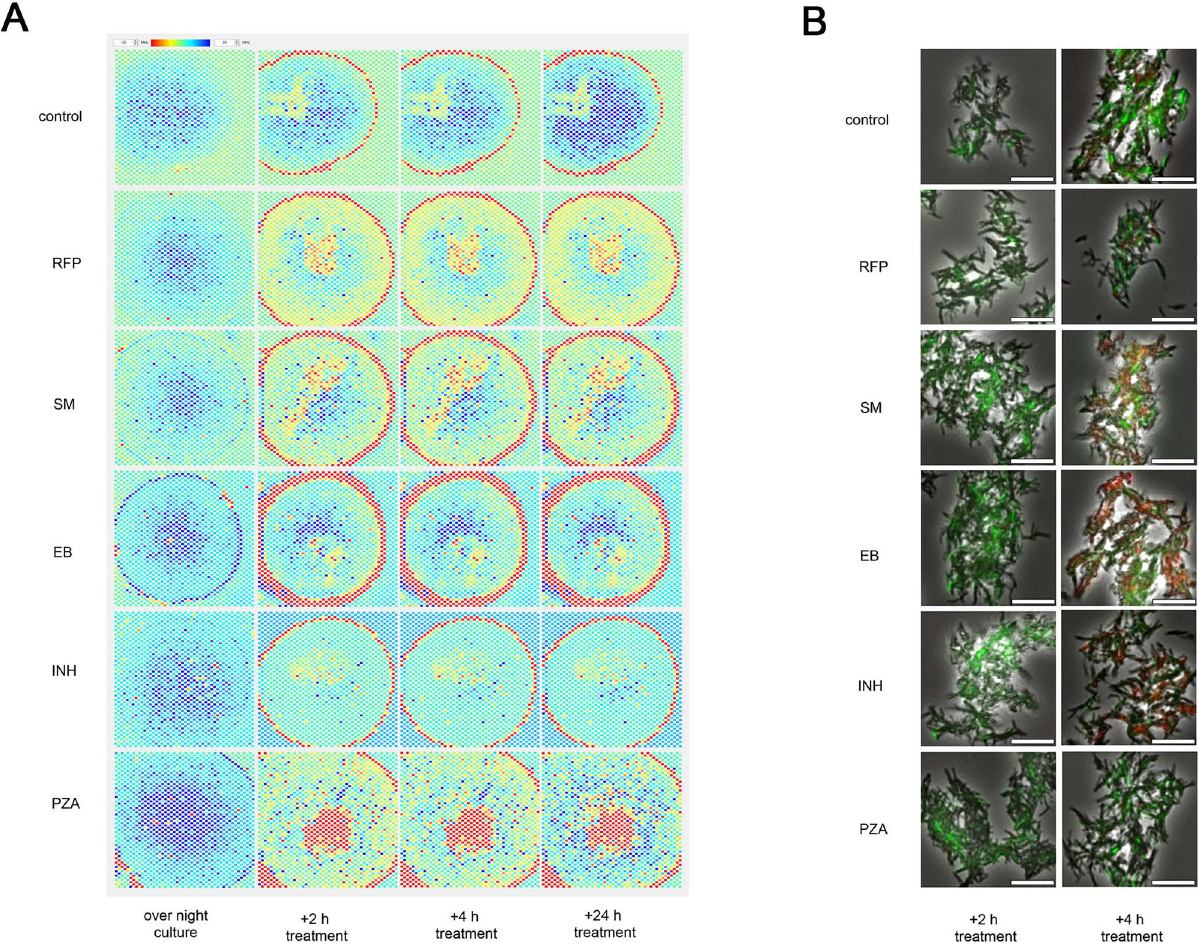
Figure 2. Growth ability and drug response sensing. ( A ) Drug susceptibility of BCG to first-line anti-TB drugs. RFP, EB, INH, PZA, and SM were each administered to a culture of BCG, and the resulting difference in resonance frequency (MHz) over 24 h is shown in heatmaps. ( B ) BCG viability assay. After 2 or 4 h of shaking liquid culture with antibacterial agent, the dead bacteria (red) and live bacteria (green) were stained with live/dead reagent. Scale bar = 20 µm. RFP rifampicin, EB ethambutol, INH isoniazid, PZA pyrazinamide, SM